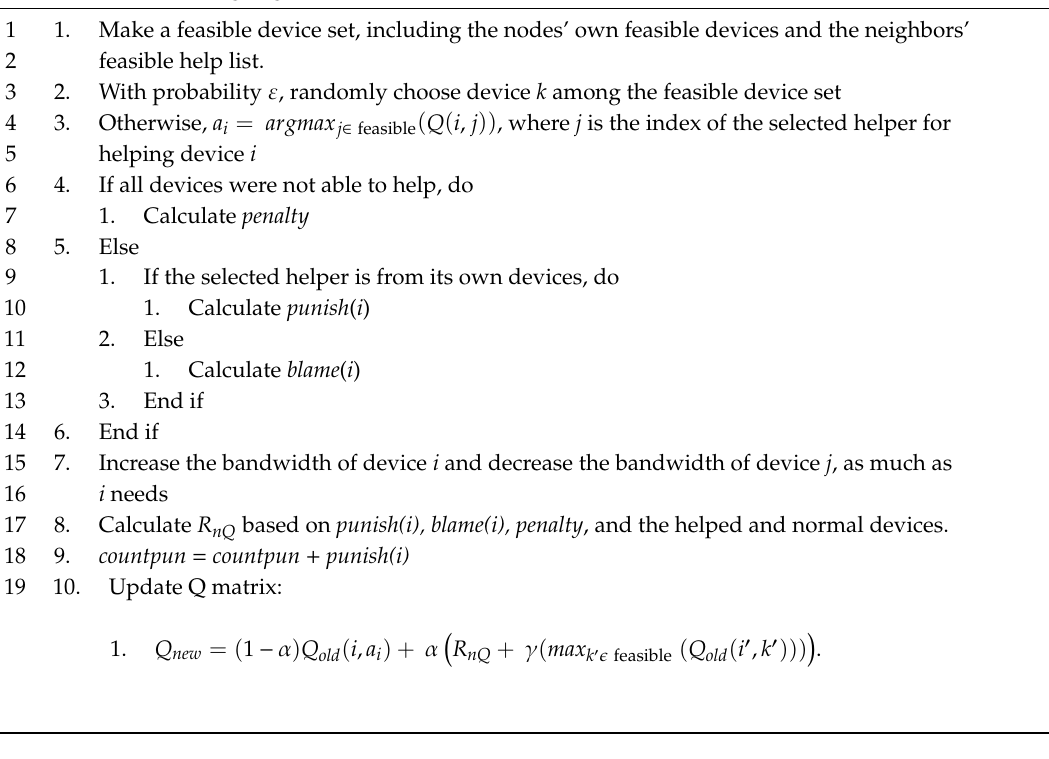
Algorithm 2 Q-learning